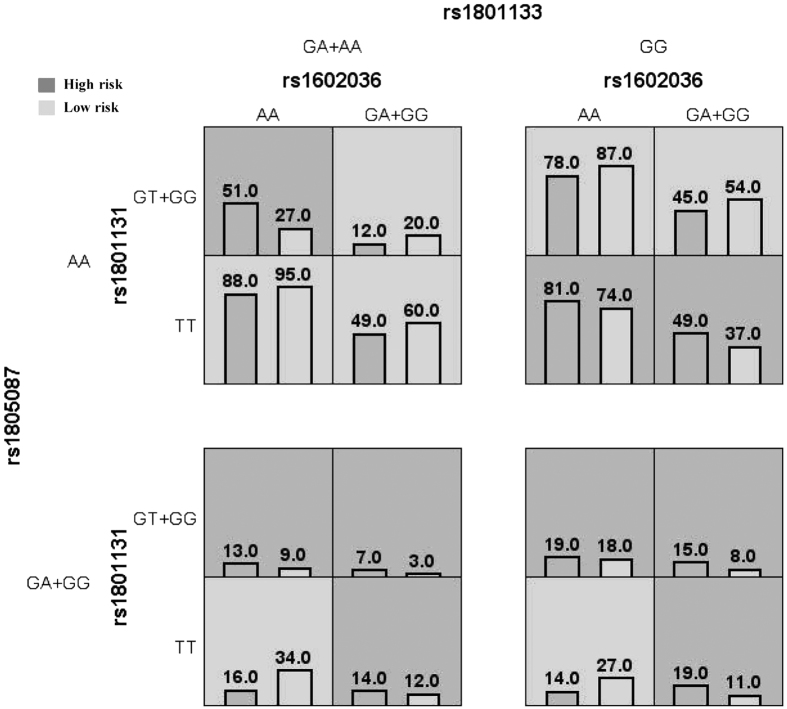
Summary of four-locus genotype combinations associated with high risk and with low risk for breast cancer.Dark gray and light gray boxes presented the high- and low-risk factor combinations, respectively. Left bars within each box represented the cases while the right bars represented the controls. The heights of the bars are proportional to the sum of samples in each group.